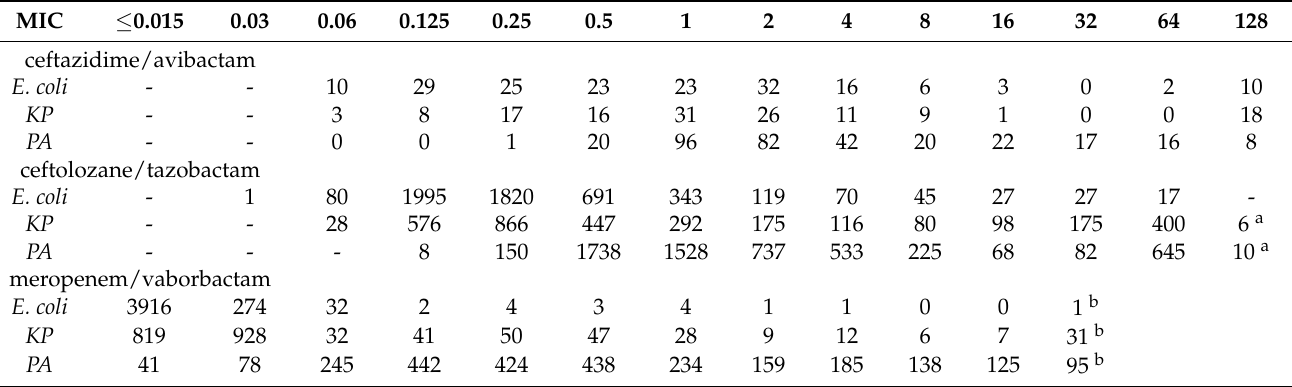
Table 4. The MIC distribution of ceftazidime/avibactam, ceftolozane/tazobactam and meropenem/vaborbactam for Enterobacteriaceae and Pseudomonas